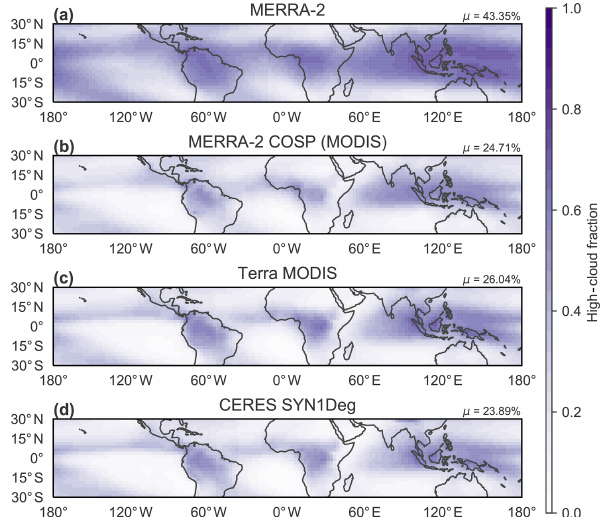
Figure 2. As in Fig. 1a but for (a) direct output from MERRA- 2, (b) MERRA-2-COSP (emulating MODIS observations of the MERRA-2 atmosphere), (c) Terra MODIS, and (d) CERES SYN1Deg (based primarily on Terra and Aqua MODIS) for 2001– 2014. The area-weighted tropical-mean (30 ◦ S–30 ◦ N) high-cloud cover based on each product is shown at the upper-right corner of the corresponding